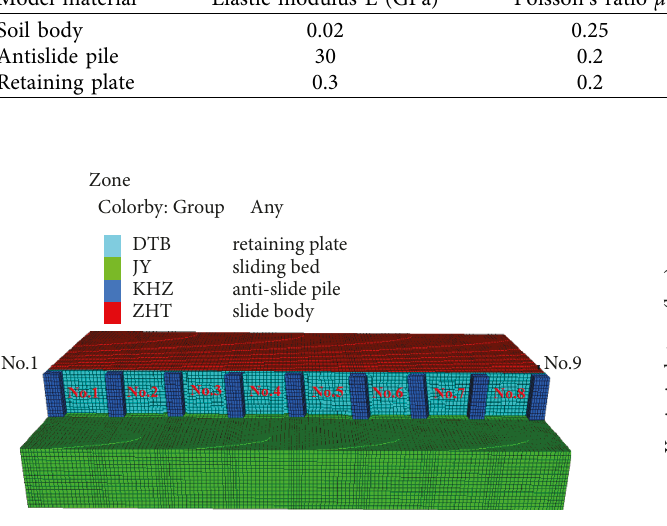
Figure 4: Model of straight line pile arrangement.